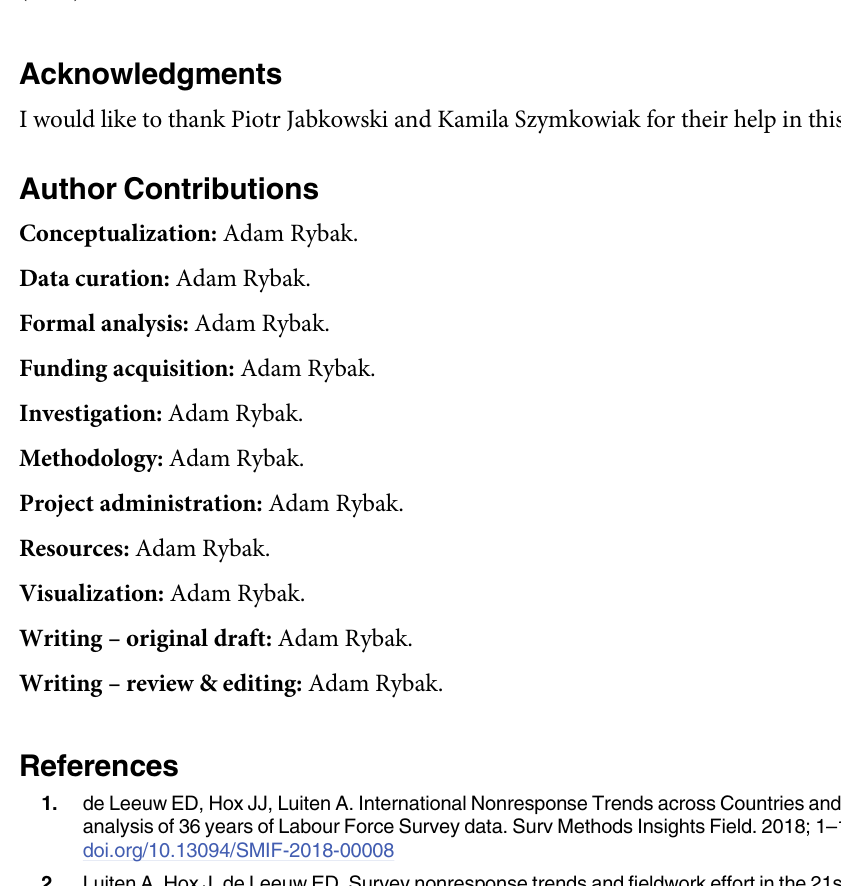
S1 Table. Two-level meta-regression model using NBI as an effect size and three-level meta-regression model using RR6 as an effect size.